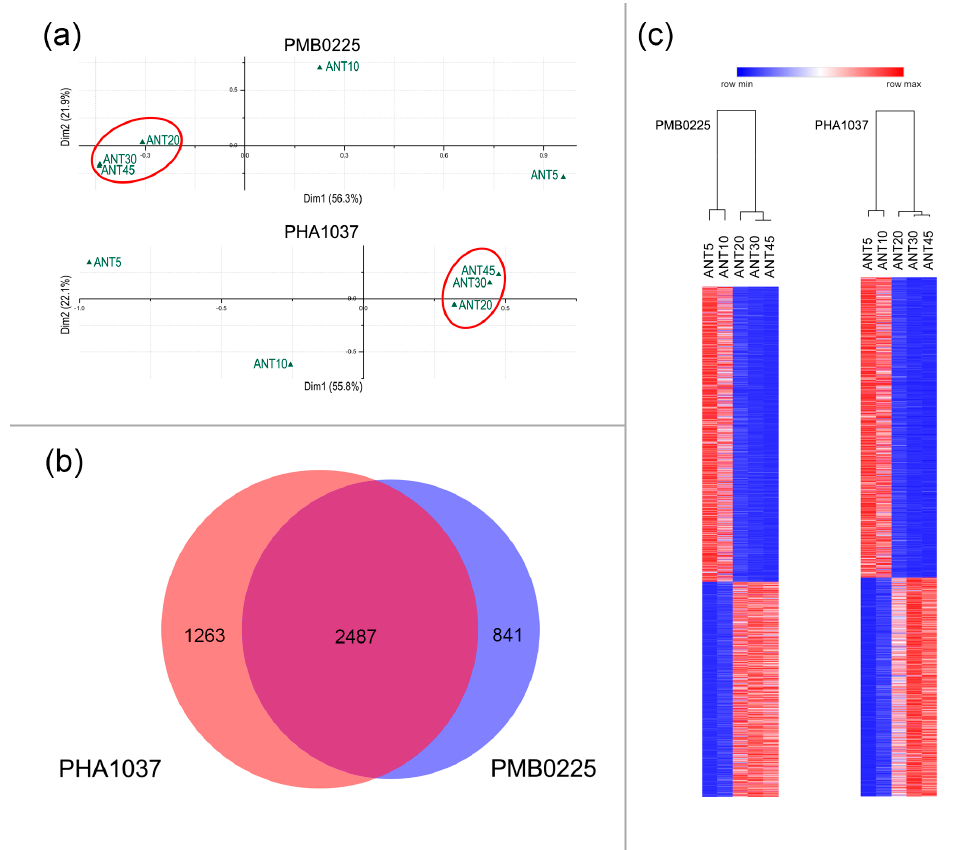
Figure 3. Genes differentially expressed between mature (ANT20 + ANT30 + ANT45) and immature (ANT5 + ANT10) pod stages. ( a ) Correspondence multivariate analyses based on all expressed genes in PMB0225 and PHA1037 along the different fruit developmental stages ANT5, ANT10, ANT20, ANT30, and ANT45. The variances absorbed by the two first factors (Dim1 and Dim2) at each plot are indicated in parentheses. Mature stages (ANT20, ANT30, and ANT45) are enclosed in red ovals. ( b ) Venn diagram of differentially expressed genes in PMB0225 and PHA1037 accessions during fruit development and maturation stages. The 2487 genes shared by both cultivars can be considered as candidate maturation genes. In addition, other 841 DE genes were exclusively found in PMB0225 and 1263 in PHA1037. ( c ) Hierarchical clustering of 2487 candidate maturation genes in PMB0255 and PHA1037 cultivars. The clusters of up- and down-regulated genes at maturation stages (ANT20, ANT30, and ANT45), as compared to the immature ones (ANT5 and ANT10), are clearly shown.